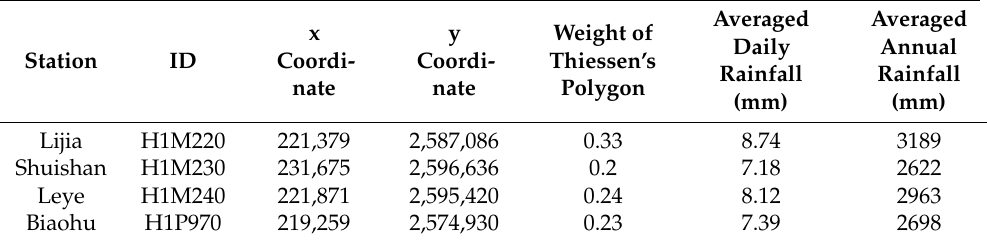
Table 2. Basic data of rainfall stations in the watershed of Zengwen Reservoir.